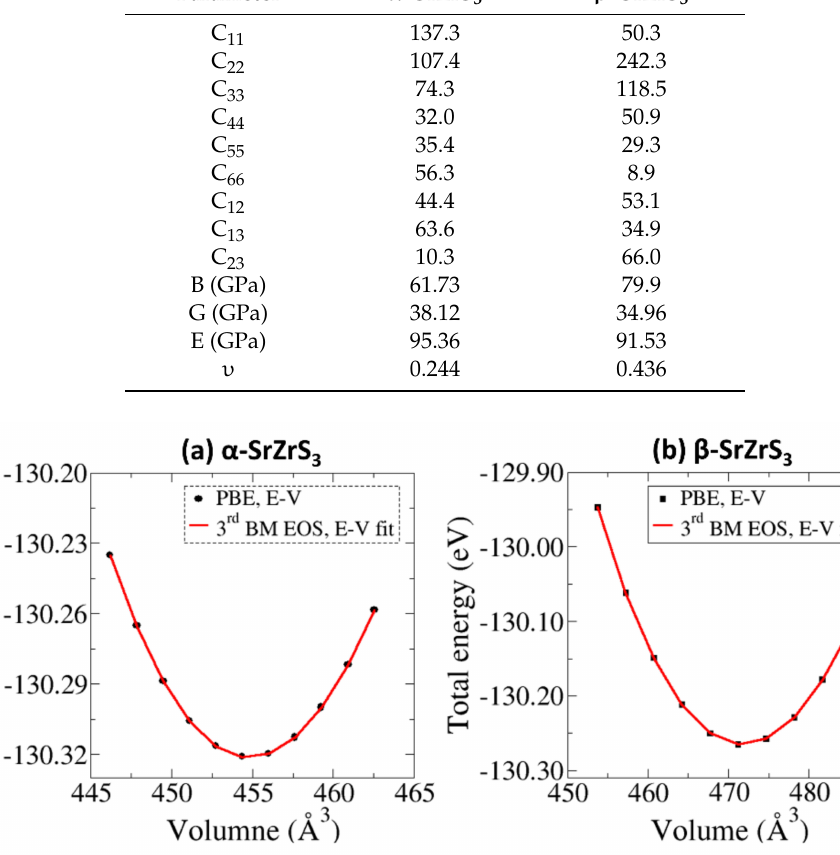
Figure 3. The third–order Birch–Murnaghan equation of state (EOS) fitting to the calculated E − V data of ( a ) α –SrZrS 3 and ( b ) β –SrZrS 3